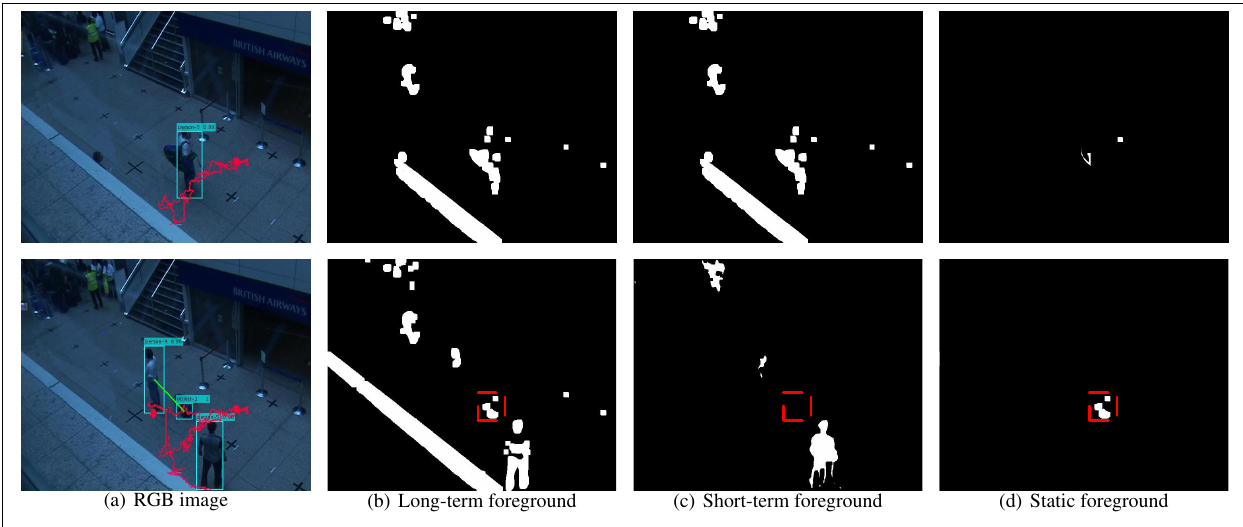
Figure 2: An example of static foreground detection in PETS 2007 dataset. The time point in the second row is 270 frames after the one in the first row. (a) shows the person/object detection (bounding box) and owner labeling (green line). The red lines are the tracking traces of detected person. (b) and (c) are the foregrounds which are extracted from the long-/short-term model respectively. (d) shows the static foreground. The place of detected bag of interest is indicated by red bounding